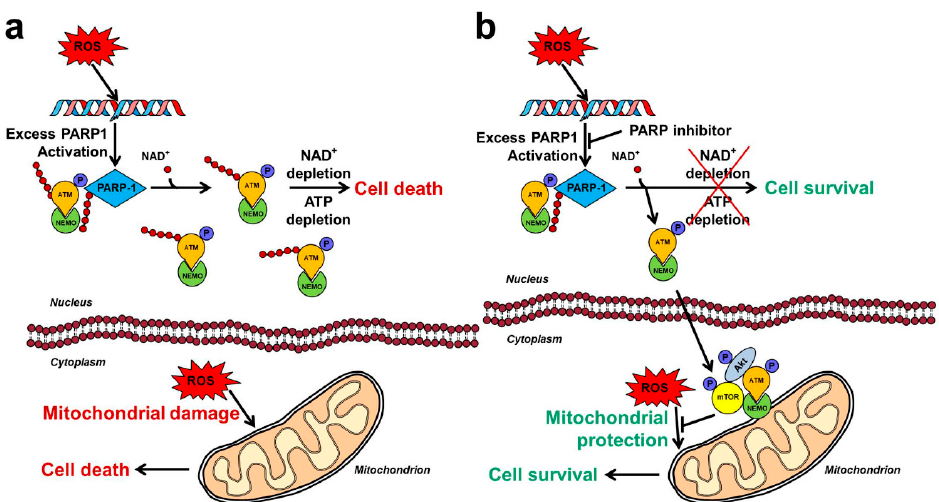
Figure 2. Schematic mechanisms of the PARP1 / Akt interplay in oxidative stress. ( a ) E ff ects of oxidative stress in the absence of PARP inhibition. Oxidative stress causes DNA strand breaks that activate nuclear PARP. Excess PARP activity exhausts the substrate NAD + that impairs ATP production. Attempted restoration of NAD + levels leads to ATP depletion and eventually cell death. ATM-NEMO complexes, even if formed, are retained in the nucleus, therefore, Akt activated cytoprotective mechanisms are inactive. The oxidative stress is free to damage the mitochondria resulting in the release of pro-apoptotic intermembrane proteins. ( b ) E ff ects of oxidative stress in the presence of PARP inhibition. The PARP inhibitor blocks excess PARP activity, thereby prevents NAD + and consequent ATP depletion. Activated ATM-NEMO complex is able to translocate to the cytoplasm and associate with the mitochondrial outer membrane. Akt and mTOR are recruited to form the ATM-NEMO-Akt-mTOR cytoprotective signalosome that prevents oxidative stress induced mitochondrial damage and activates various cell survival pathways. Pointed arrows denote activation while arrows with flat end represent inhibition. P indicates